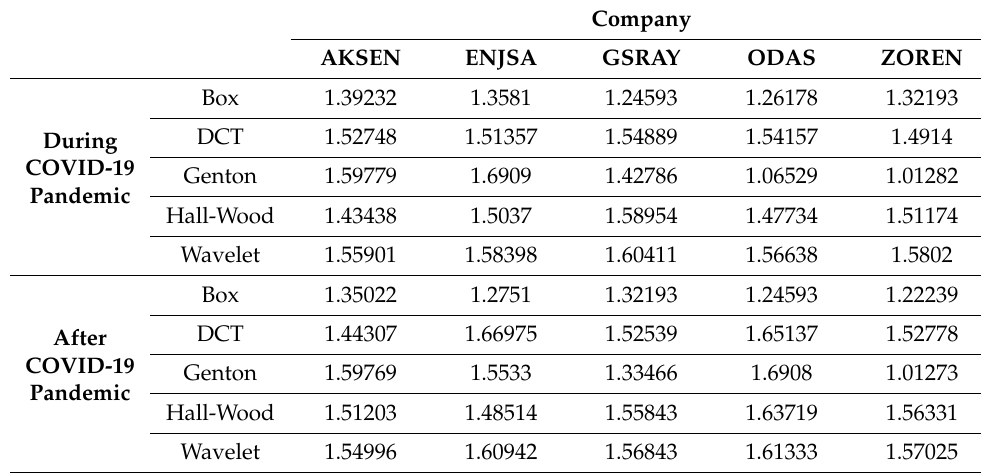
Table A2. Fractal dimensions for the energy sector.